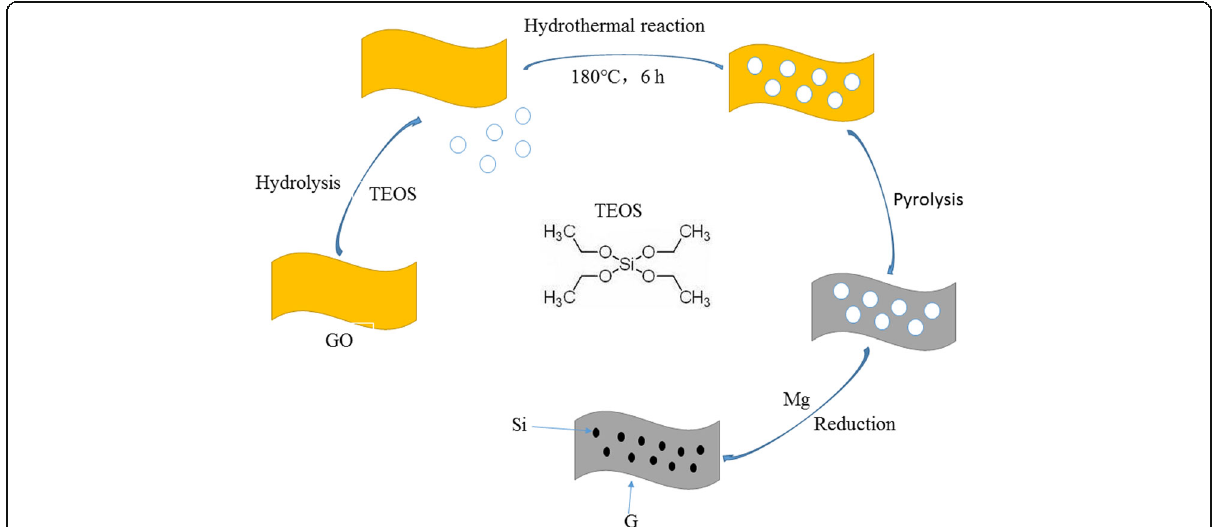
Fig. 1 Schematic diagram of the preparation procedures for